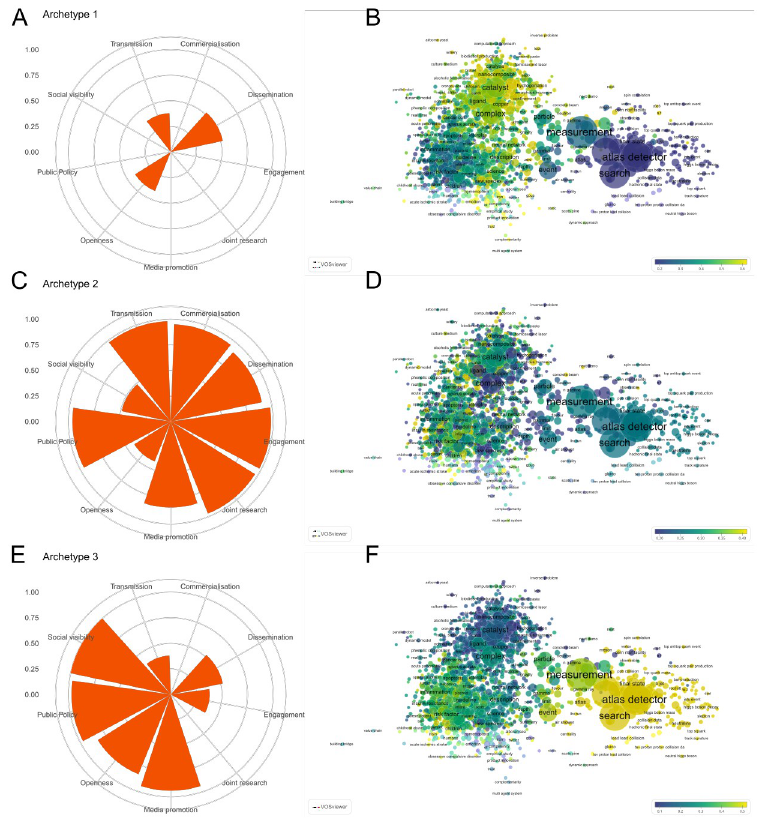
Fig 3. Parameters and topic maps for three archetypes in all fields of science. Archetypes that emerge for all cases (A, C and E), the variables transmission, commercialisation, dissemination, engagement and joint research have been rescaled (0–1) to allow comparisons with the rest of the variables. Archetype parameters are shown in percentiles. Overlay maps of α scores corresponding to words included in the titles of research publications (B, D and F). Words follow a colour grading based on their maximum or minimum value, the extreme values being yellow (for those present in publication titles of cases resembling a given archetype) and blue (those which are not present in the publication titles of cases resembling the archetype). An online version of this map is available at: http://sl.ugr.es/ allarchetypes.